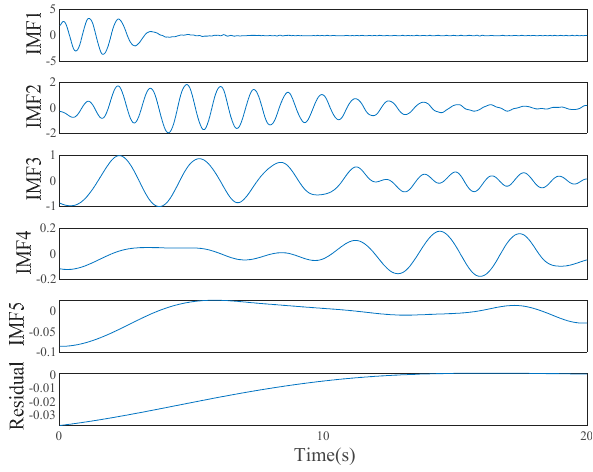
Figure 10. Effective IMFs and a residual signal of signal B.